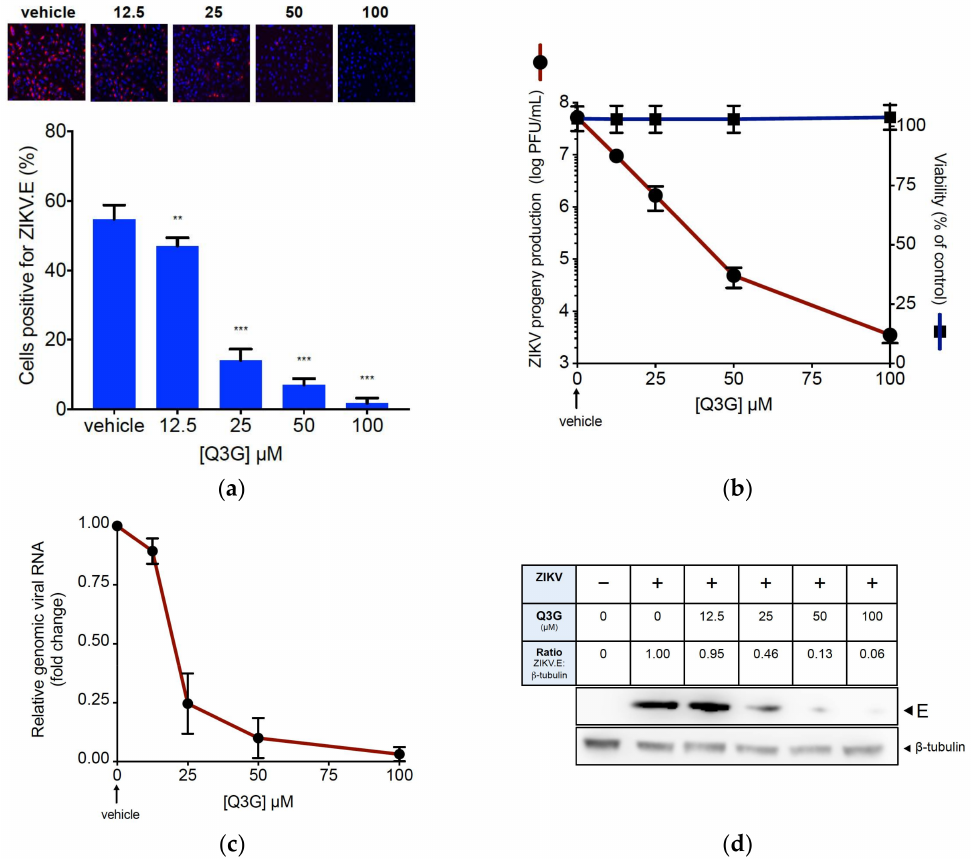
Figure 1. Q3G prevents infection of A549 cells by epidemic strain of ZIKV. A549 cells were infected 24 h with PF-25013-18 at a multiplicity of infection (MOI) of 2 in presence of increasing concentrations of Q3G or vehicle. In ( a ), immunofluorescence analysis of viral protein expression in ZIKV-infected A549 cells. The ZIKV envelope E protein (ZIKV.E) (red) and nuclei (blue) were visualised by fluorescence microscopy. The same magnification of × 20 was used throughout. Results from a representative experiment ( n = 4 repeats) are shown. Bottom panels: quantification of positive cells for the viral protein E expression in ZIKV-infected A549 cells. In ( b ), ZIKV progeny production was quantified by plaque-forming assay (PFU). Data represent the means ± SD of four independent experiments performed in triplicate. In ( c ), the amount of viral genomic RNA in ZIKV-infected A549 cells was determined by RT-qPCR. Results are expressed as fold change of viral RNA transcripts in ZIKV-infected and Q3G-treated cells relative to those in vehicle-treated cells. Data represent the means ± SD of four independent experiments performed in triplicate. In ( d ), detection of intracellular E protein in ZIKV-infected A549 cells by immunoblot assay using anti-E mAb. β -tubulin served as loading control. Bands were quantified by densitometry using ImageJ software (Version 2.0.0; National Institutes of Health, Bethesda, MD, USA) and the ZIKV.E: β -tubulin ratio values are indicated in the